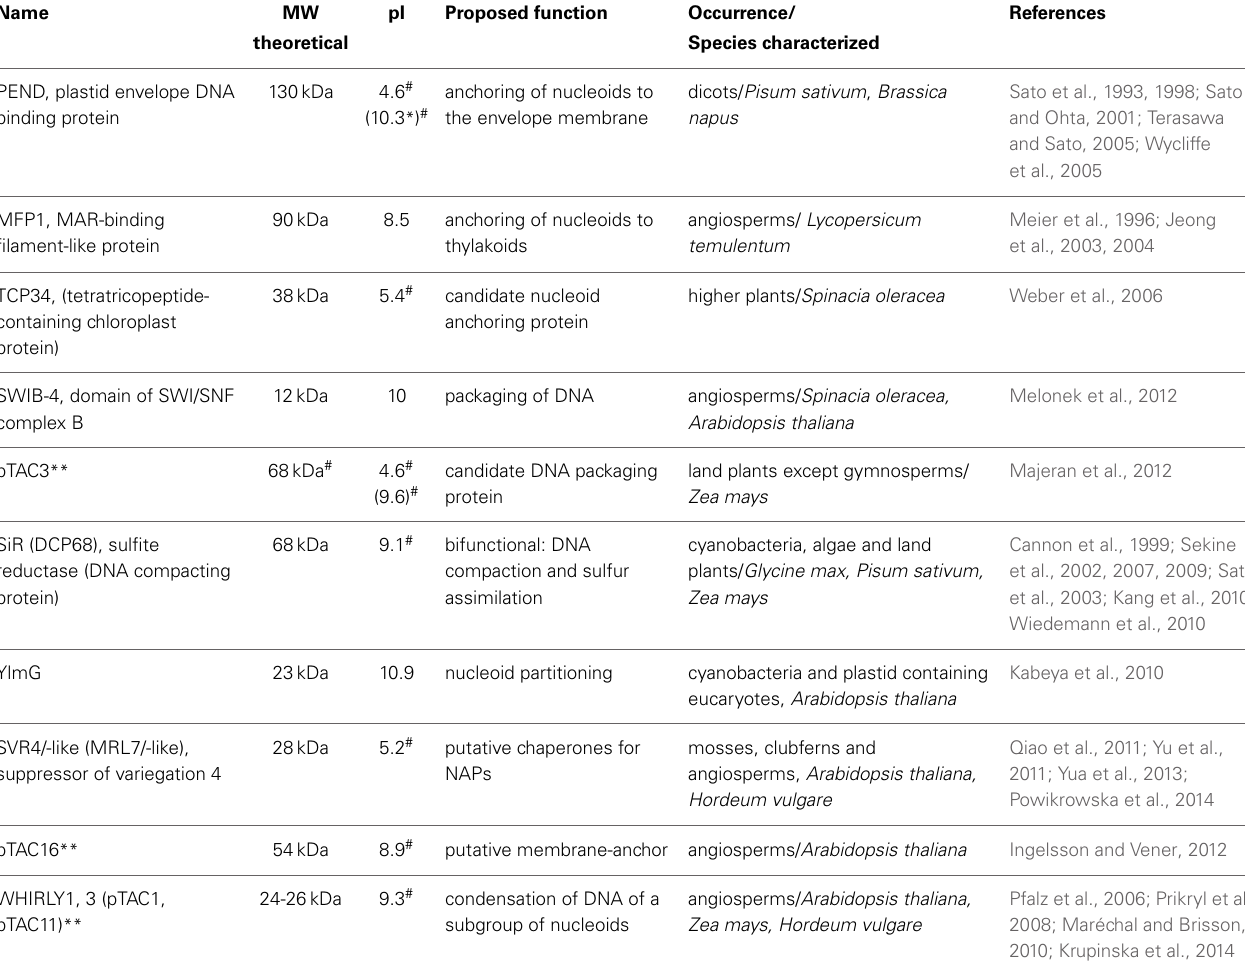
Table 1 | Characteristics of plastid nucleoid associated proteins proposed to be involved in shaping and organization of nucleoids in plants.